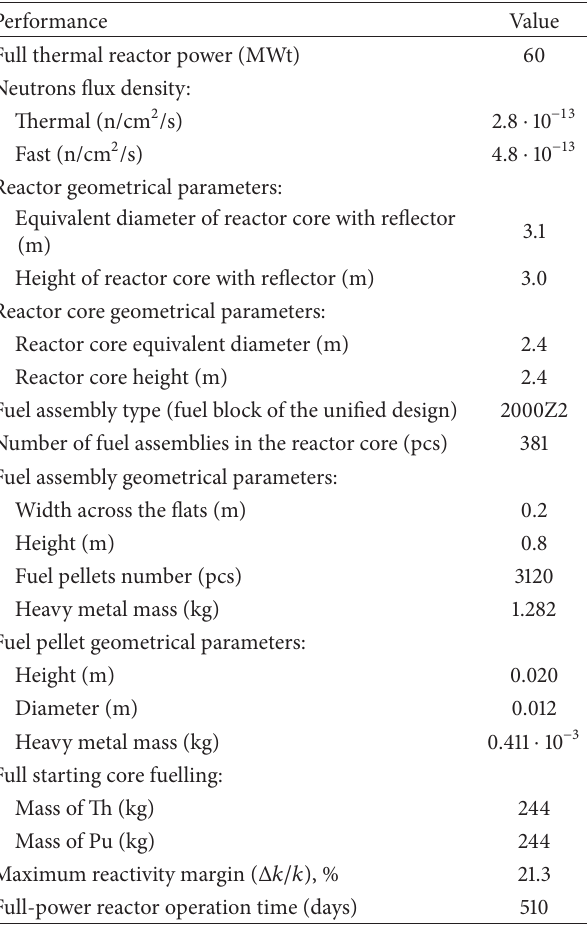
Figure 6: Radial power density distribution in the large core. Table 4: Basic design parameters of the